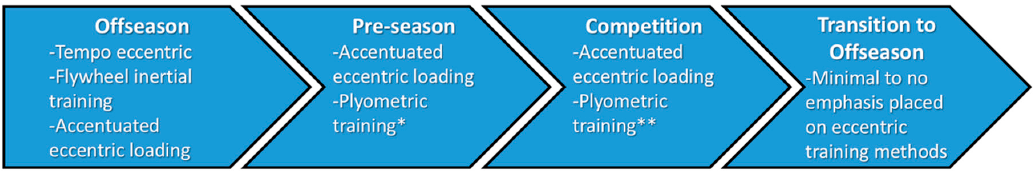
ff erent phases of the